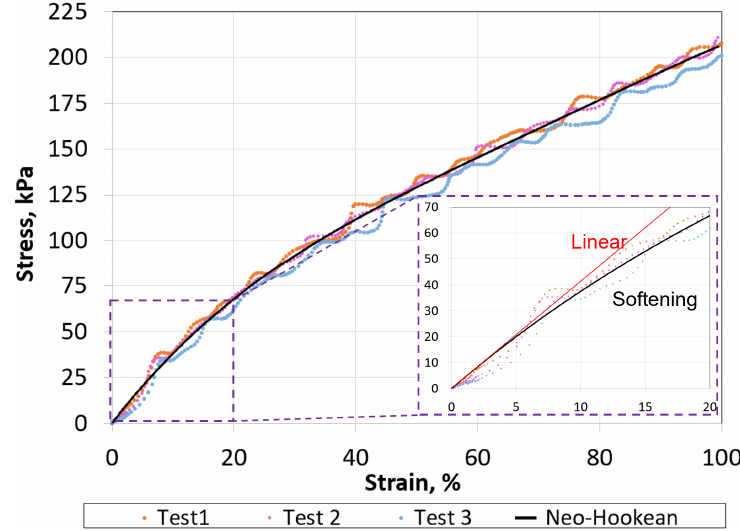
Figure 12. Neo-Hookean hyperelastic constitutive model shows good agreement with the experimen- tal stress–strain response of the soft material. The inset plot shows the nonlinear response at low strains, which is the softening (black curve) region in Figure 4. The straight red line highlights the nonlinear